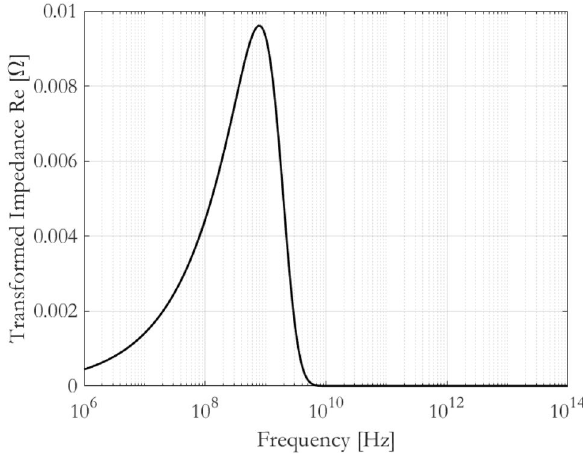
Figure 2. Real part of transformed impedance according to values in Table 1. Lossless case considered (i.e. real and negative value of electrical permittivity).